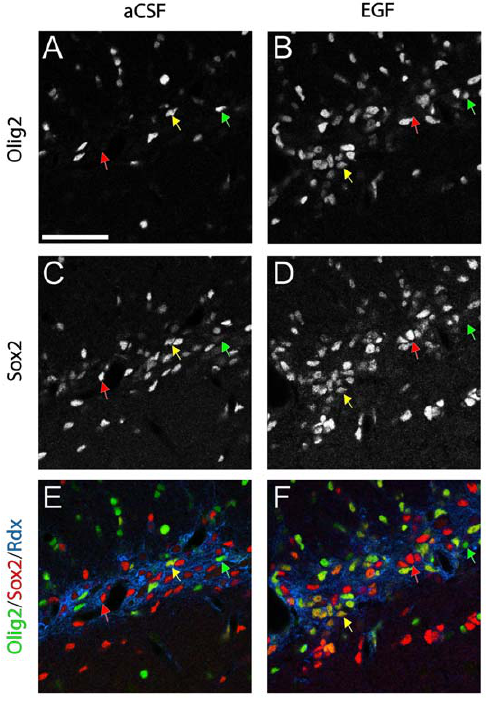
Figure 9. Olig2/Sox2/radixin co-expression in the rostral migratory stream. ( A, B ) Increased Olig2 immunoreactivity was observed after EGF infusion. ( C, D ) Olig2 2 /Sox2 high cells (red arrows) were found in both control and EGF-treated rostral migratory stream (RMS) ( A, C, E ) In the control RMS, Olig2 positive cells are few and either Sox2 negative (green arrows) or express Sox2 high ( B, D, F ) The expanded radixin + /Olig2 + population in the EGF-treated RMS express Sox2 high (yellow arrows). ( E, F ) Olig2 + cells negative for Sox2 were observed under both conditions (green arrows). Scale bar in A=50 m m.